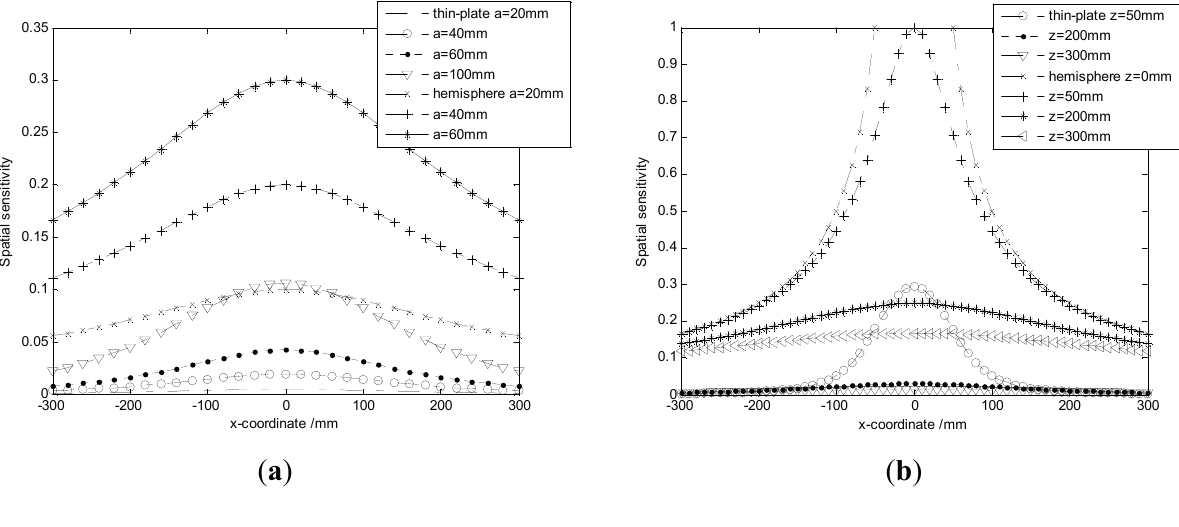
Figure 6. Variations of the spatial sensitivity with x for different radii ( a ) and z ( b